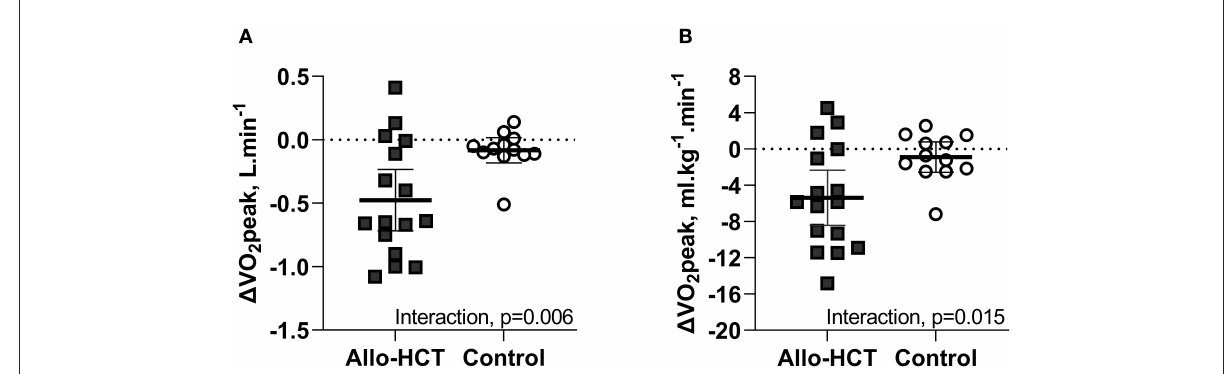
FIGURE1 (A,B) Mean (95% CI) 3-month change from baseline in absolute and bodyweight-indexed VO 2 peak in Allo-HCT and Control assessed by cardiopulmonary exercise testing. There was a significant between-group difference for the net change from baseline for absolute and bodyweight-indexed VO 2 peak ( p = 0.006 and p = 0.015, respectively), which was due to a significant decrease in allo-HCT and no change in